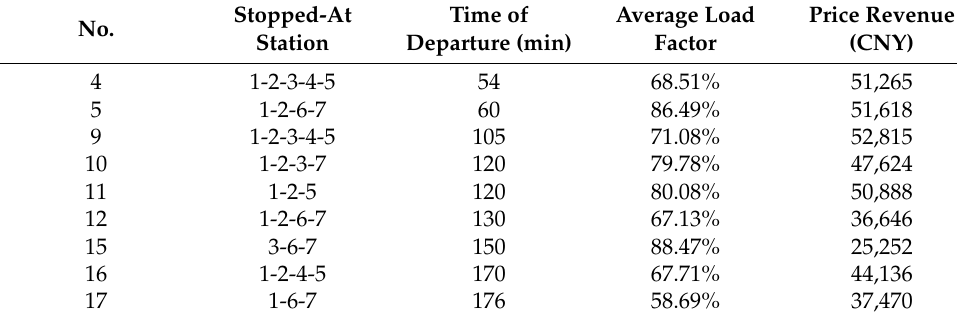
Table 5. The information of all operated trains of the small-scale case.